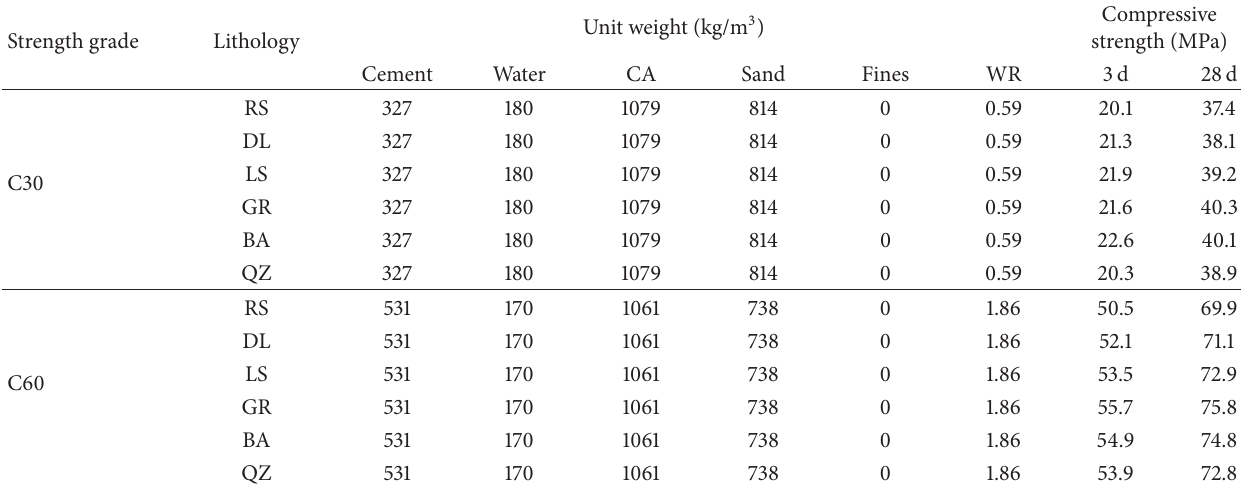
Table 5: Concrete mix proportions and strengths of resultant